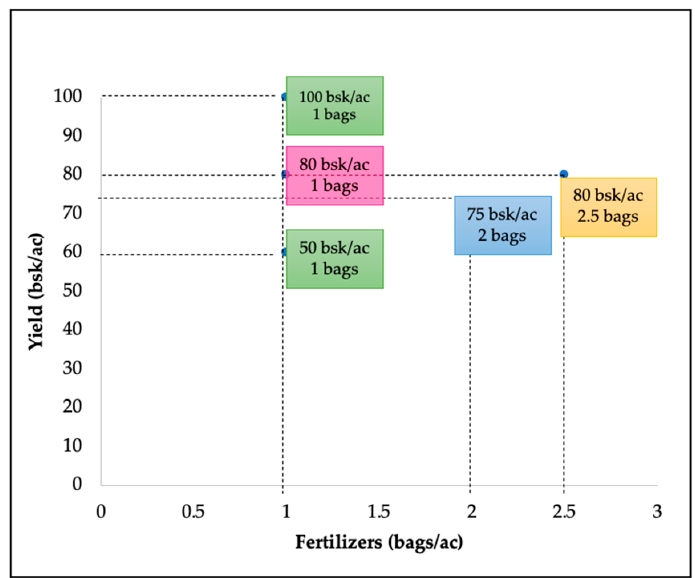
Figure 5. Diagram used to help explain the relationship between yield and fertilizer (participation of farmers from Type 4). Bag = 50 kg bag of fertilizer, 1 bsk = 20.9 kg of rice.